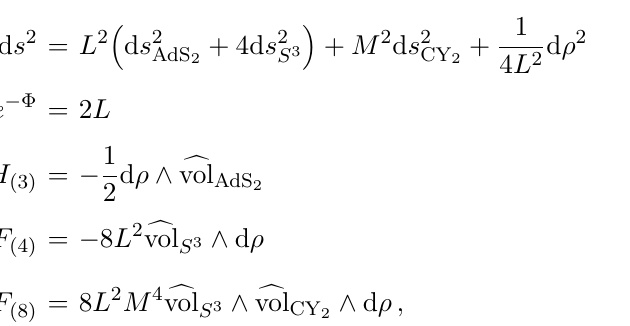
and the solution